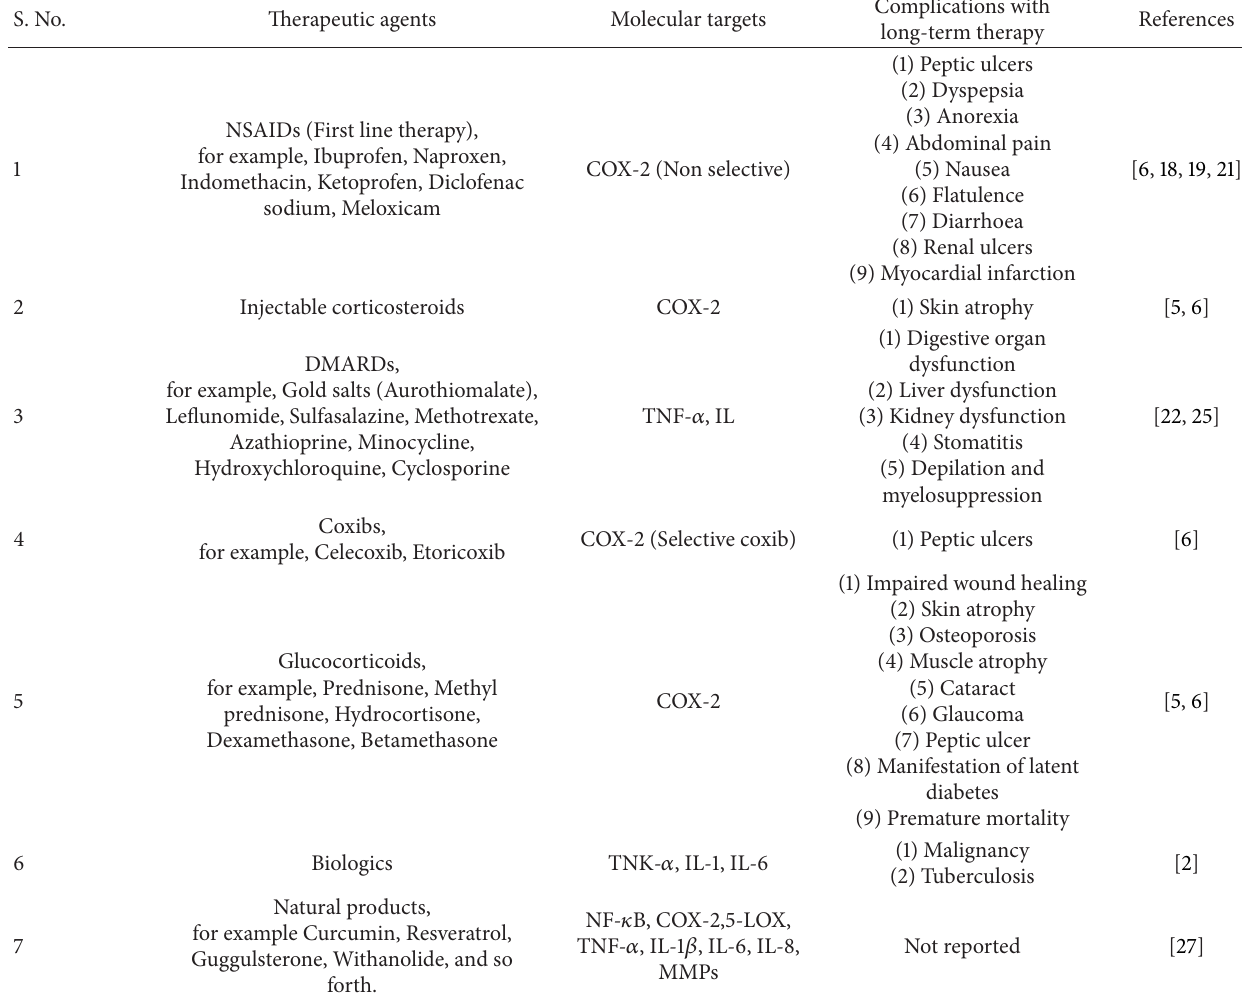
Table 1: Molecular targets of antirheumatic therapeutic agents and their complications. S.